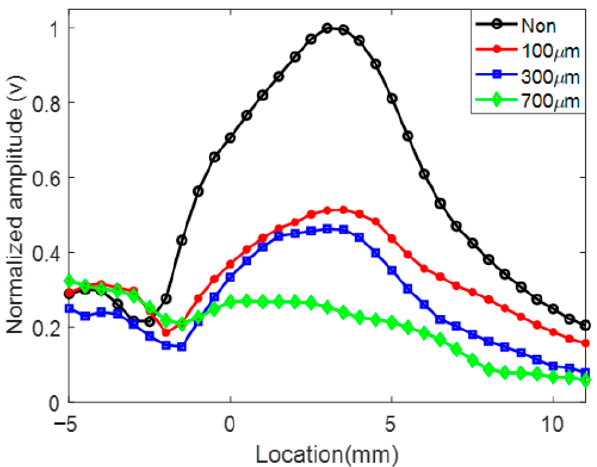
Figure 11. Experiment result of amplitude profiles of Axial defect type.